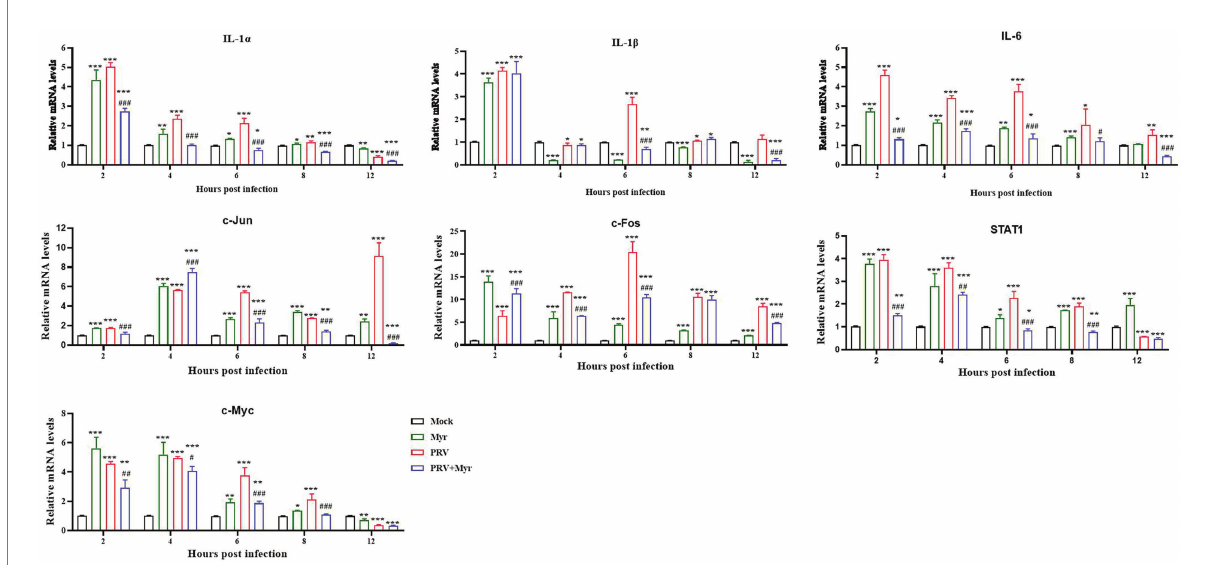
FIGURE 6 Gene expressions. The PK-15 cells were infected with or without PRV (MOI = 1) in the presence or absence of myricetin. The total mRNA of each sample was extracted at 2, 4, 6, 8, and 12 hpi, respectively, and subjected to real-time PCR to test the expressions of the target genes of NF- κ B (IL-1 α , IL-1 β , and IL-6) and MAPKs (c-Jun, STAT1, c-Fos, and c-Myc) signaling pathways. Mock, the uninfected-untreated cells; Myr, the uninfected group with myricetin treatment; PRV, the infected group without treatment; PRV + Myr, the infected group with myricetin treatment. Data are presented as mean ± SD, n = 6. Symbols “*, **, and ***” represent p < 0.05, p < 0.01, and p < 0.001, respectively, between the mock group and other groups. Symbols “#, ##, and ###” represent p < 0.05, p < 0.01, and p < 0.001, respectively, between the PRV group and PRV + Myr